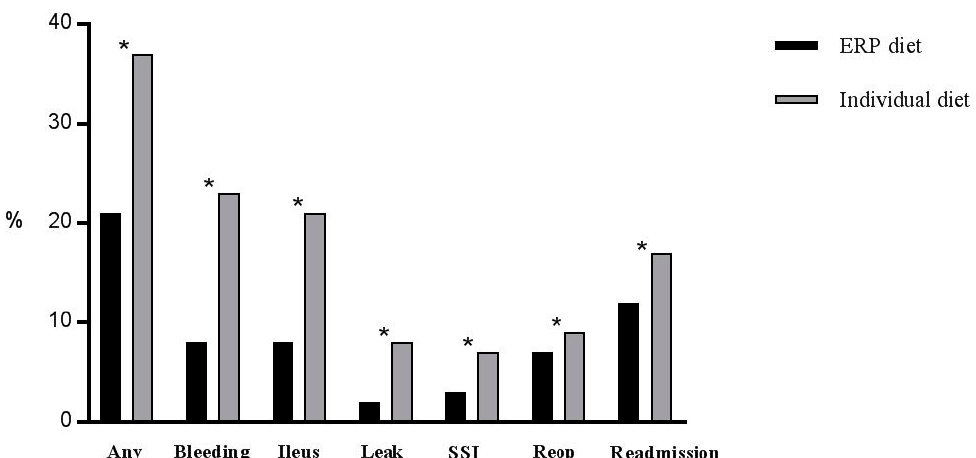
Figure 1. Outcome. Postoperative complications in patients assigned to the ERP re-alimentation pattern ( n = 5862) and patients assigned to an individualized re-alimentation pattern ( n = 1241). Any complication: Clavien grade I-V, ERP—enhanced recovery pathway, SSI—surgical site infection, reop—reoperation. * indicates statistical significance ( p < 0.05).